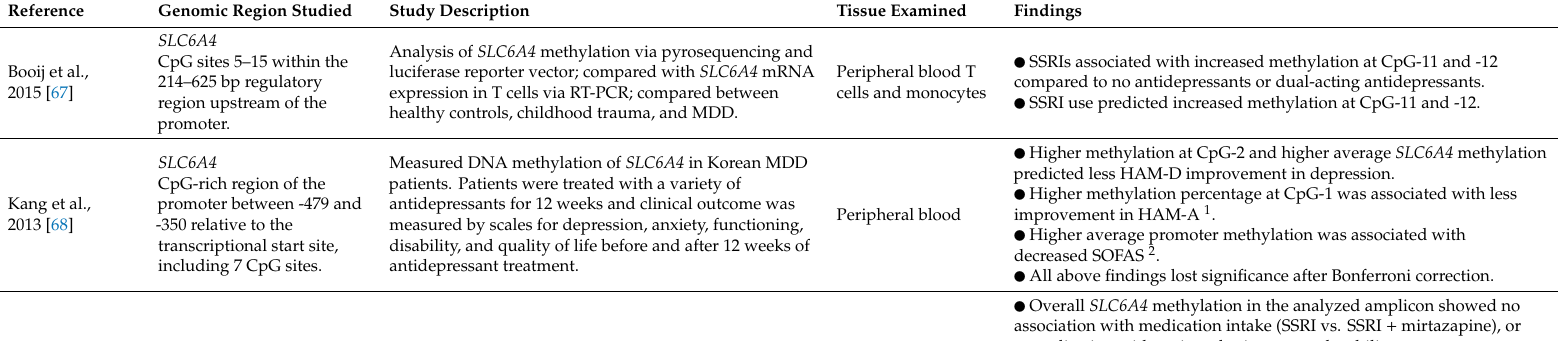
Table 3. Summaries of studies exploring relationship of antidepressants and DNA methylation of serotonin and norepinephrine transporter genes. Reference